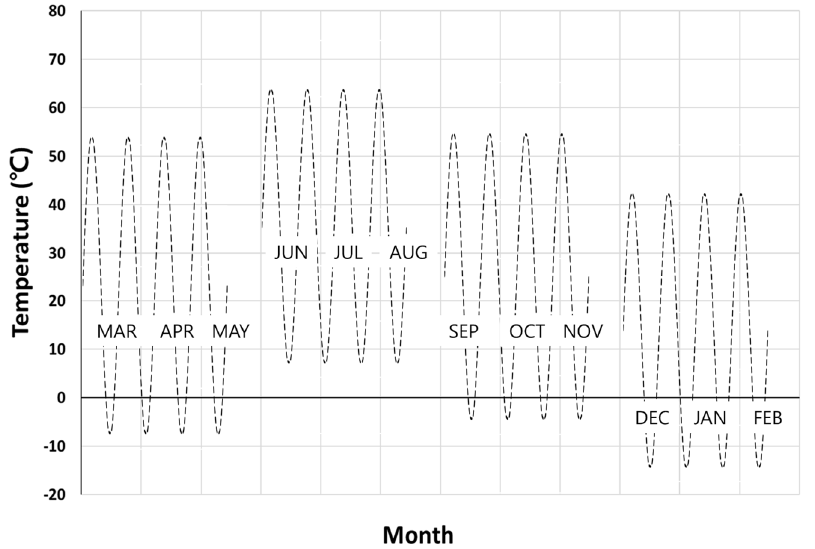
Figure 3. Four-year average quarterly seasonal temperature cycle estimated from the monthly av- erage cycle (temperature varied daily, and the graph is a scheme where daily temperatures are made into a monthly average).